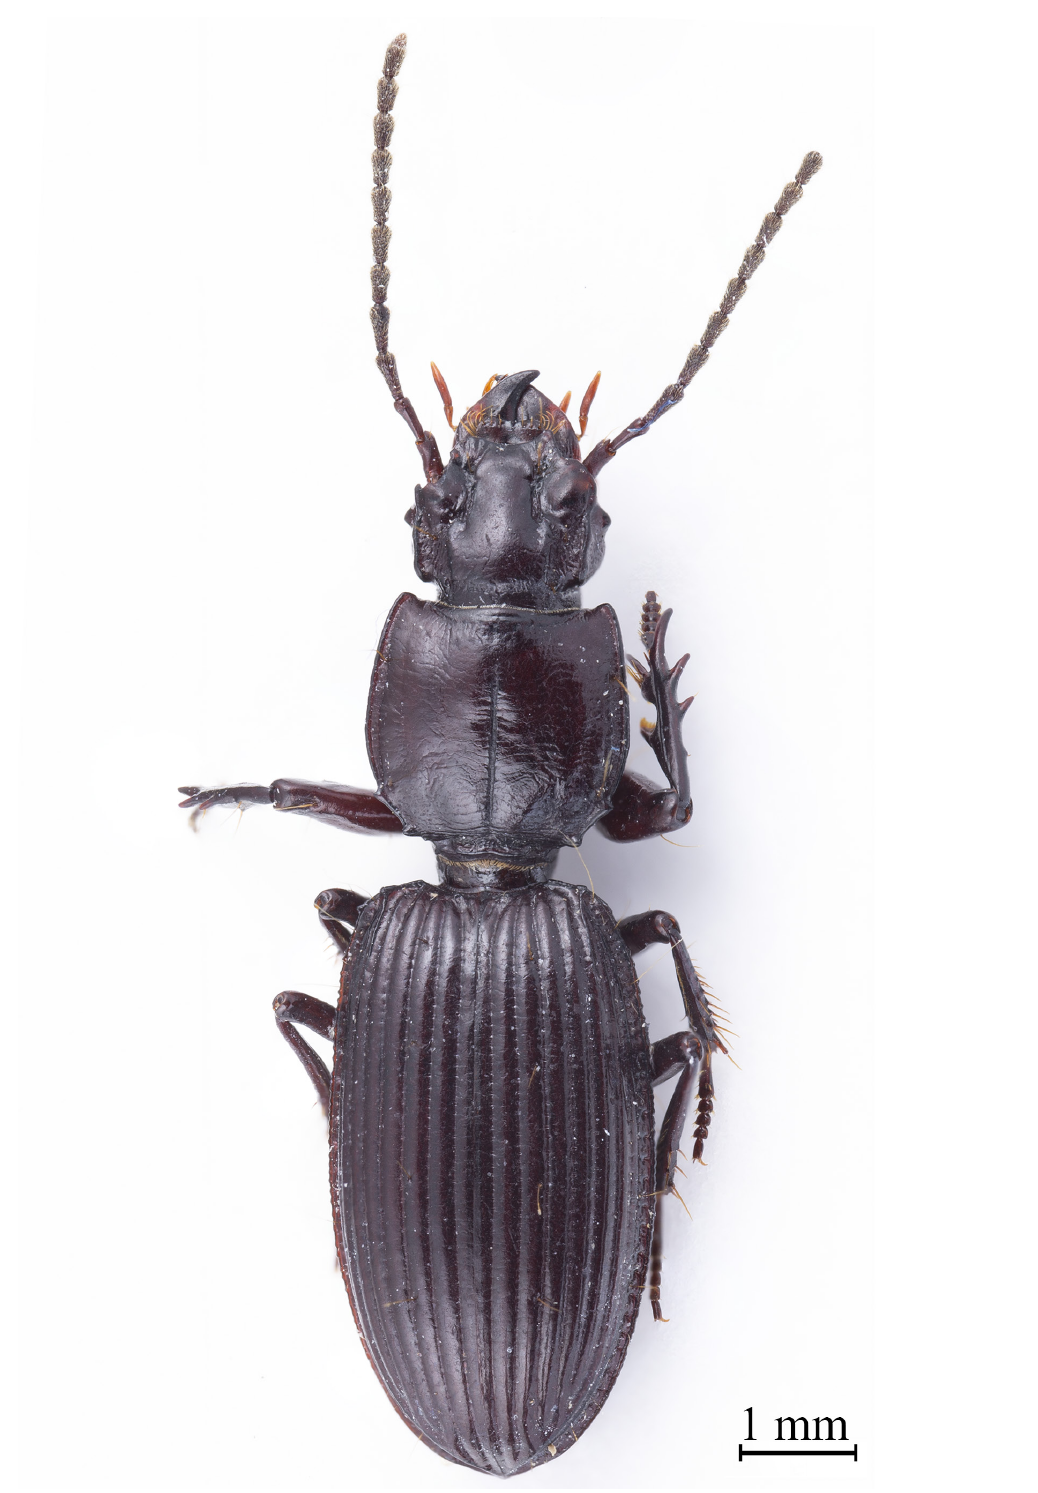
Fig. 7. Habitus of Guiodytes yueliangensis Huang & Tian sp. nov., holotype, ♂